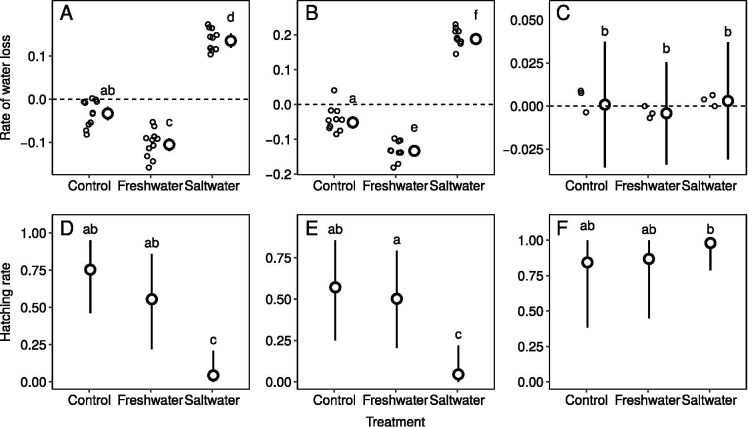
Rates of water loss (RTWLs, A-C) and hatching rates (D-F) of eggs in three lizard species in Taiwan. RTWLs of eggs of E. longicaudata (A), D. swinhonis (B), and H. frenatus (C). The hatching rates of eggs of E. longicaudata (D), D. swinhonis (E), and H. frenatus (F) in three days. Circles and vertical bars present the posterior mean and 95% credible intervals of RTWLs, respectively. Letters above the bars present the results of the post hoc comparisons; two groups sharing the same letter(s) indicate no significant difference. Post hoc comparisons of RTWLs and hatchling rates were analysed separately.